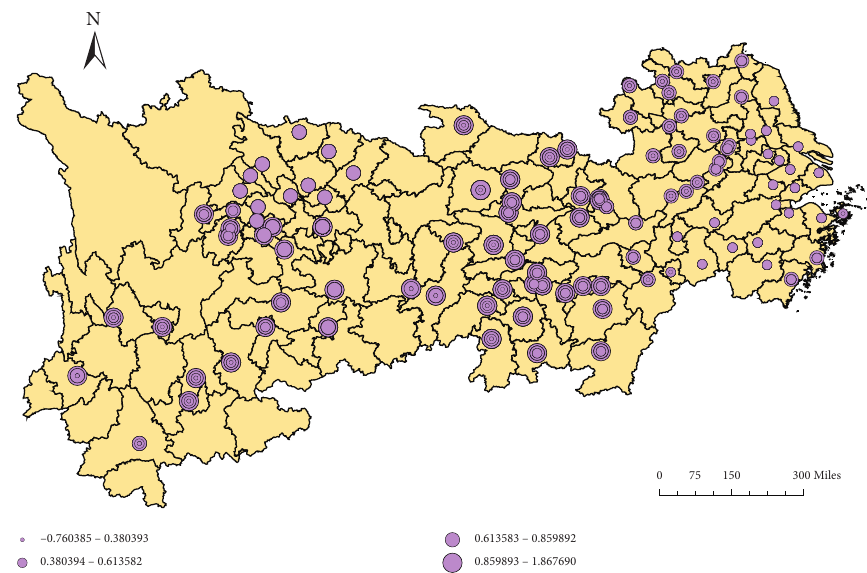
Figure 1: Spatiotemporal distribution of dominant socioeconomic